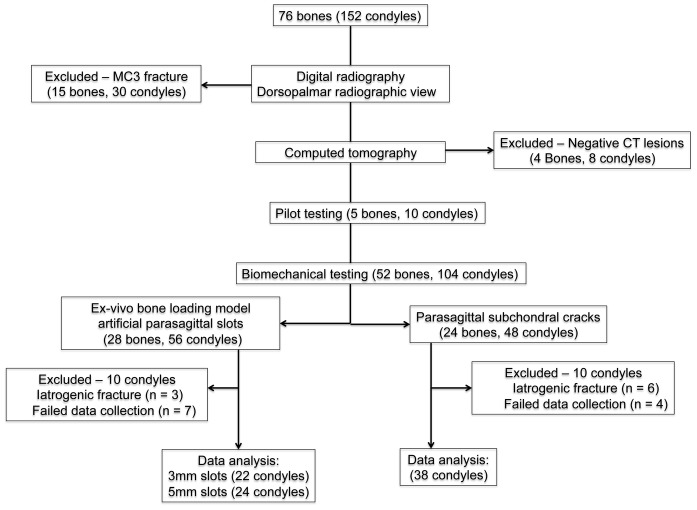
Flow diagram for limb inclusion and exclusion.Of the 152 condyles from 76 limbs horses initially screened, 38 condyles with naturally occurring subchondral fatigue cracks were ultimately studied in detail.